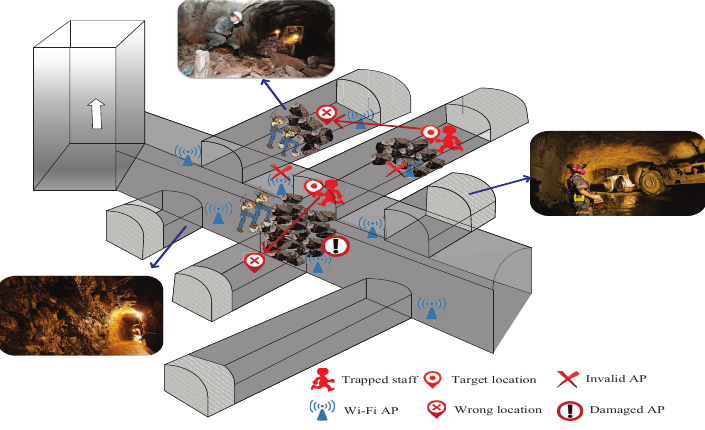
Figure 1. Problem